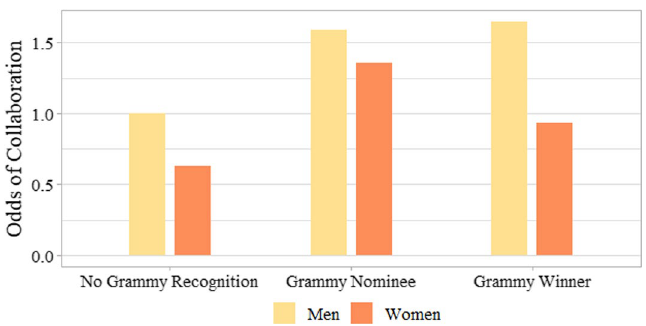
Fig. 2 Odds of collaboration by gender and Grammy